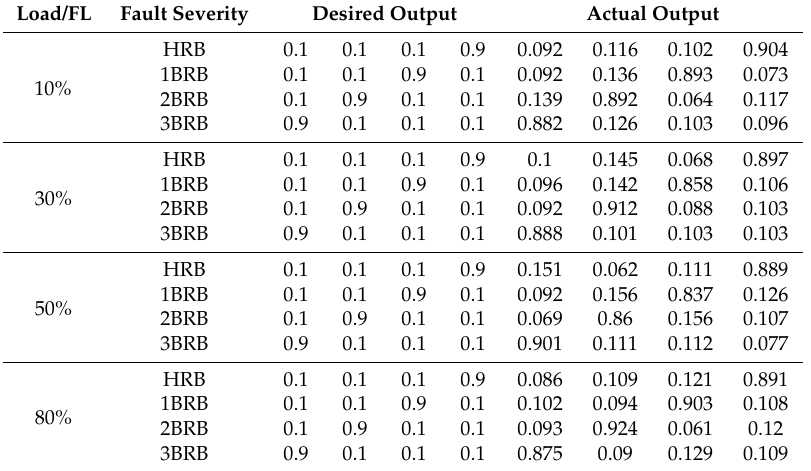
Table 9. Desired and Actual Output in all Load Conditions.